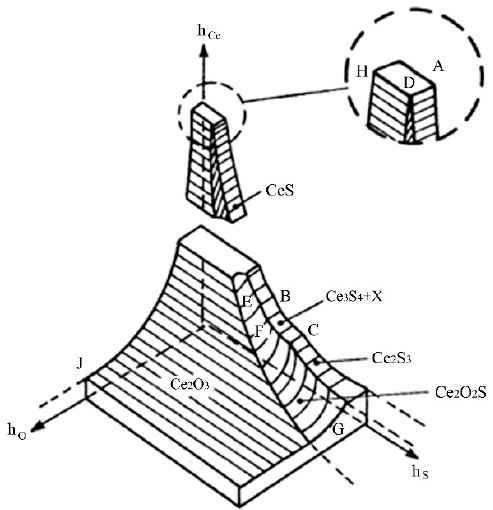
Figure 8. Inclusion precipitation diagram for the Fe-Ce-O-S system at 1627 °C. h Ce , h O , and h S represent Henrian activities of cerium, oxygen, and sulfur, respectively, reproduced from Reference [33], with permission of Springer, 2016.